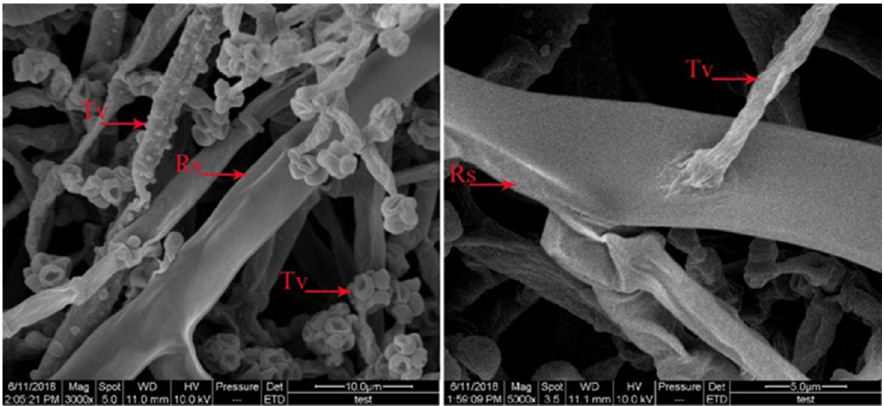
Figure 2. Electron microscopic observation of T. virens ZT05 and R. solani in dural culture (Tv, T. virens ZT05 and Rs, R. solani ).